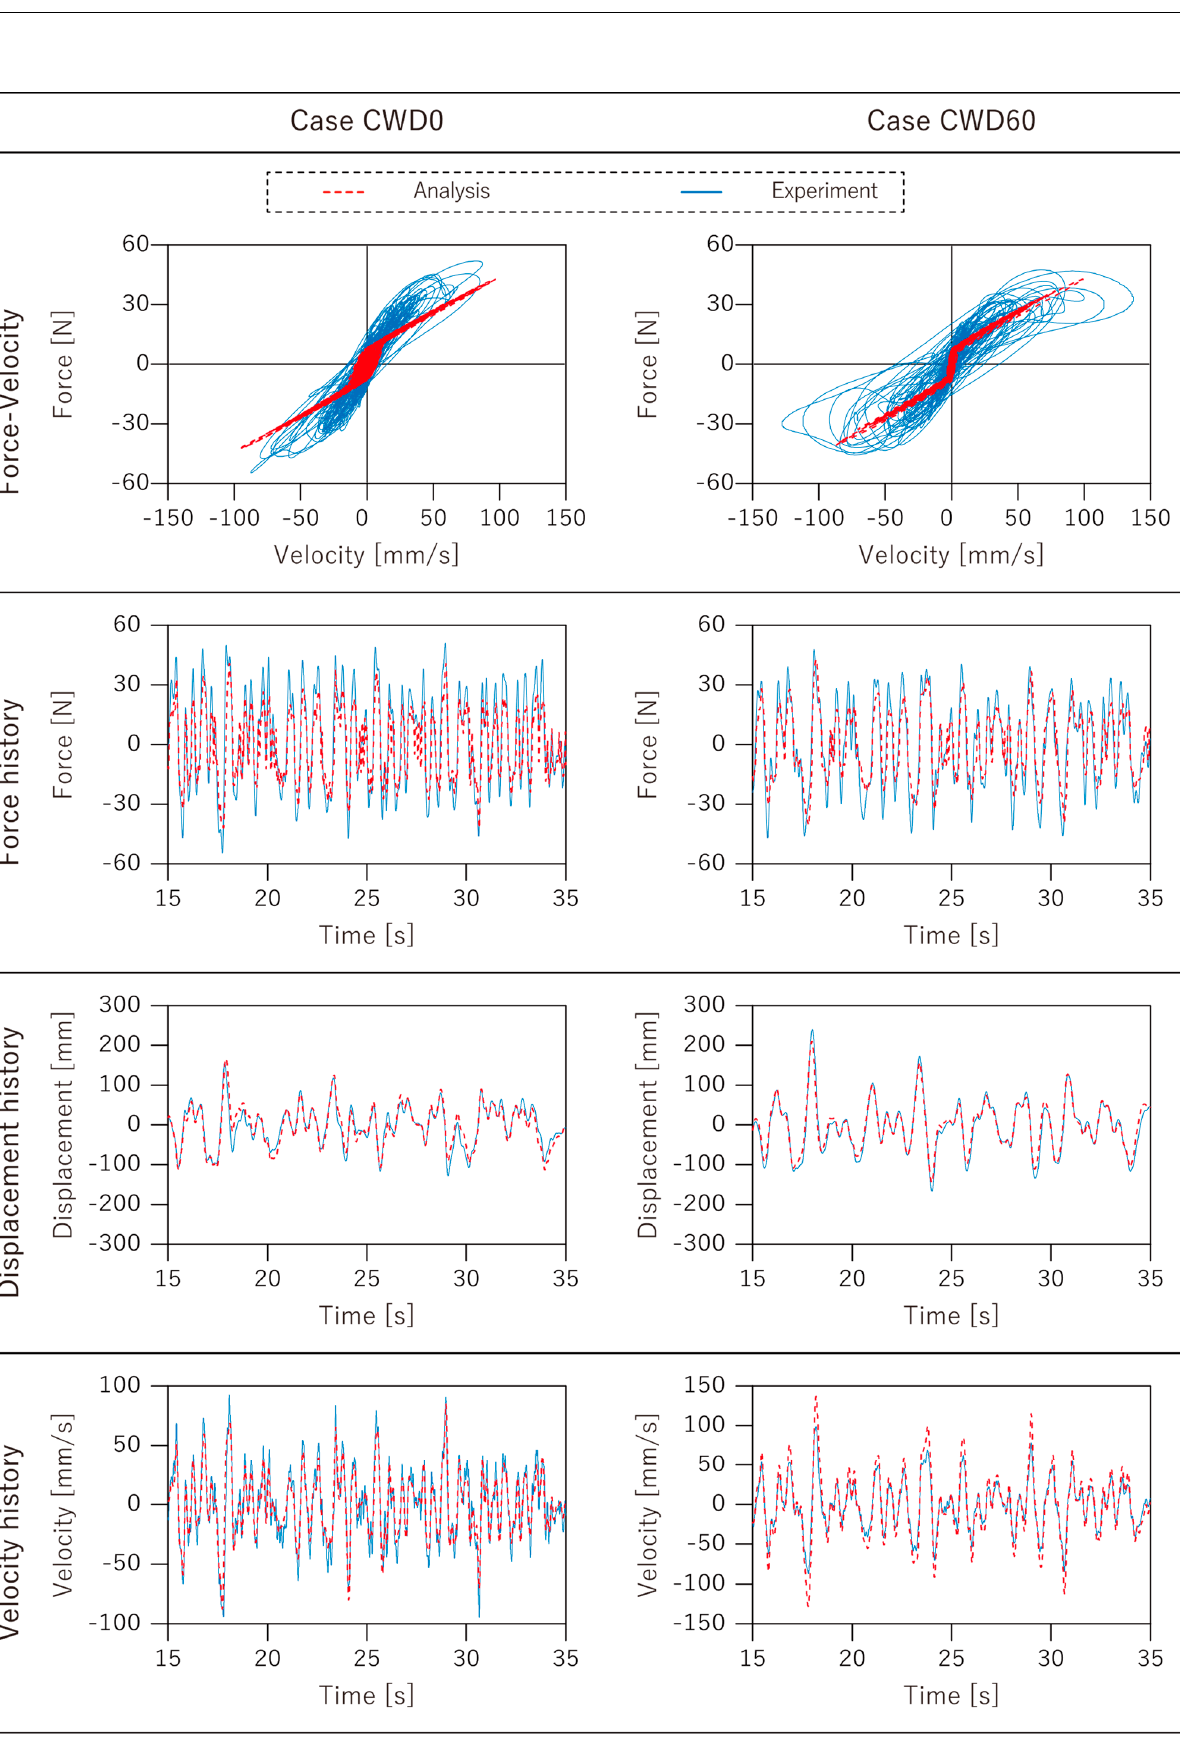
Figure 24. Results comparison of the damper response between shake table test and simulation anal- ysis.